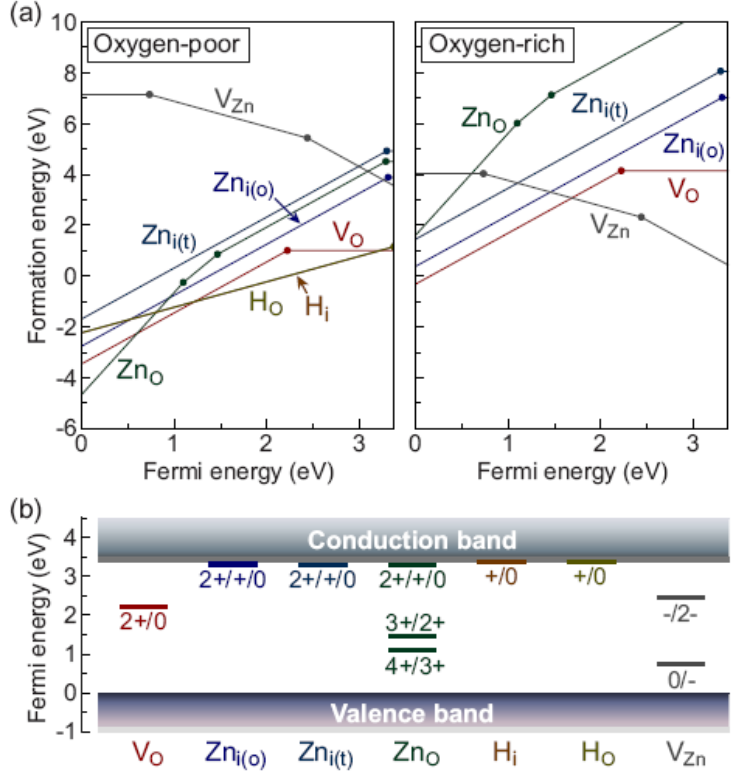
Figure 11. (a) Defect formation energies as a function of the Fermi energy at the oxygen-poor and oxygen-rich limits, (b) Defect thermodynamic transition levels. Reprinted from Ref. [62] with